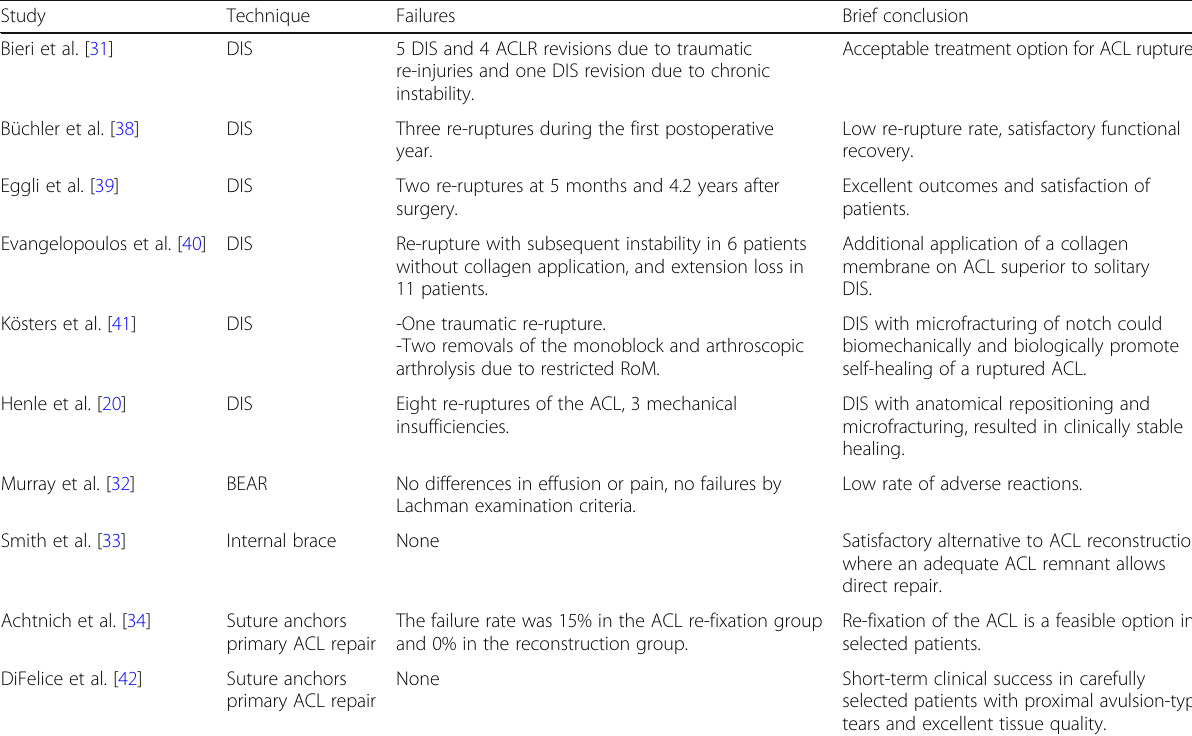
Table 3 Clinical studies: failure rate and a brief conclusion per study